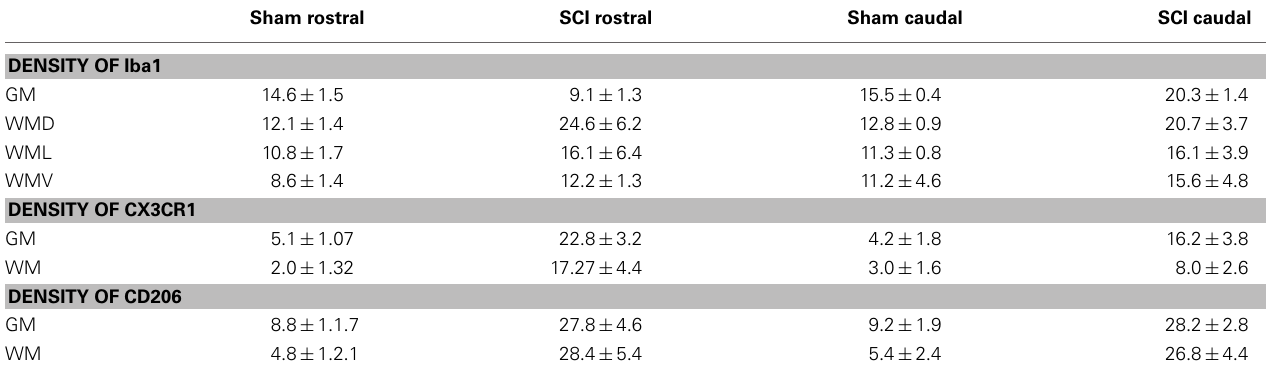
Table 3 | Quantification of Iba1, CX3CR1 and CD206 immunoreactivities in sham, SCI tissue from rostral and caudal segments at 3 days. Sham rostral SCI rostral Sham caudal SCI